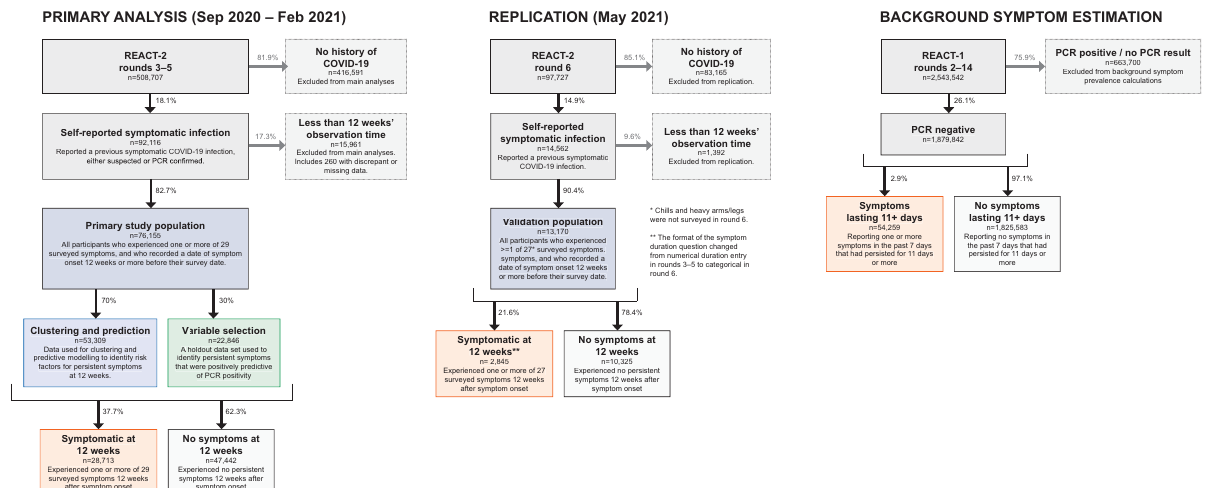
Fig. 1 Study population fl ow chart. An overview of primary and replication study population size, with exclusions and proportion of participants experiencing symptoms 12 weeks after symptom